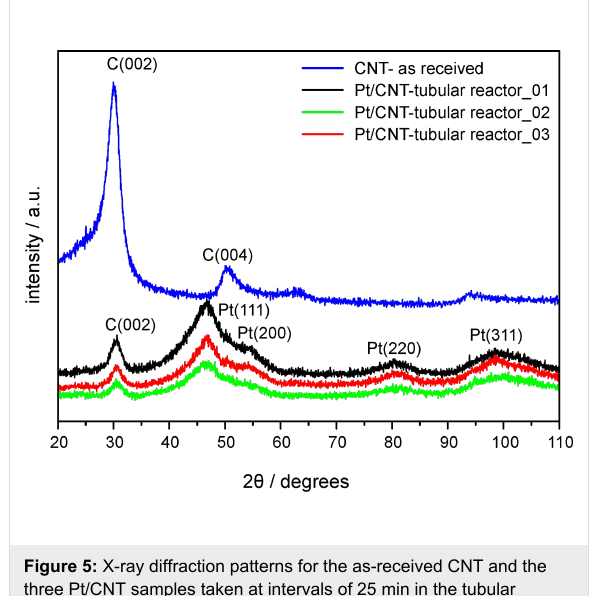
Figure 5: X-ray diffraction patterns for the as-received CNT and the three Pt/CNT samples taken at intervals of 25 min in the tubular